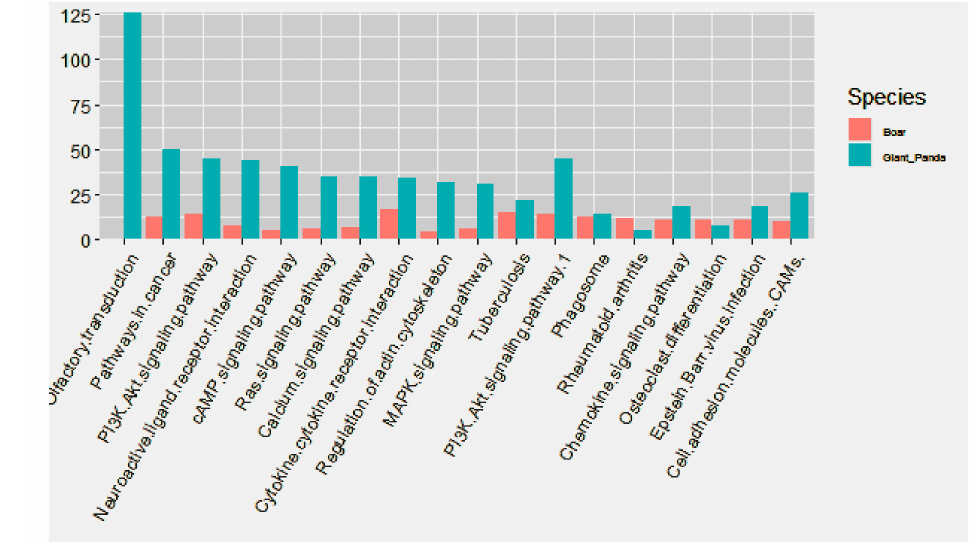
Figure 5. Comparison of top ten KEGG pathways of DE mRNAs in boar and giant panda sperm. The most enriched pathway was olfactory transduction, followed by pathways in cancer and PI3K-AKT signaling